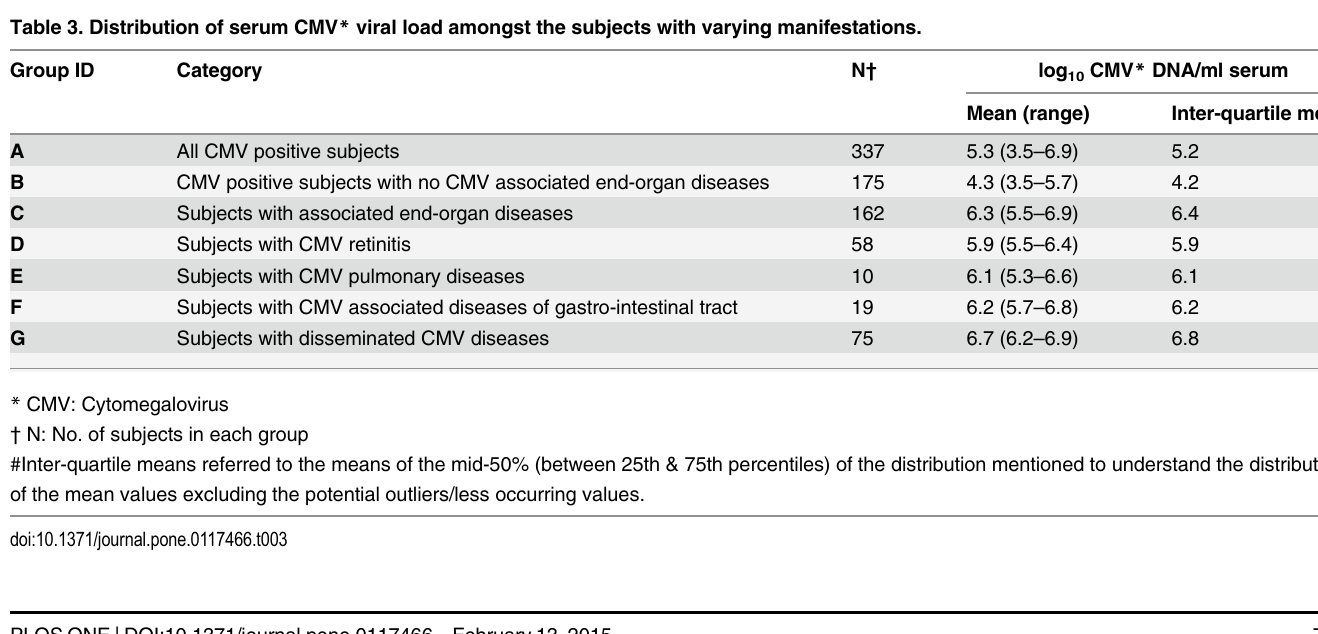
The mortality rate among the subjects with CMV EODs was significantly higher at a low CD4 count of < 30 in comparison to those at a higher CD4 count of 30 – 59 [OR: 0.37 (95%CI 0.14 – 0.96) P = 0.04; RR:0.67 (95% CI 0.49 – 0.93) P = 0.01] and CD4 from 60 – 100 [OR:0.09 (95%CI